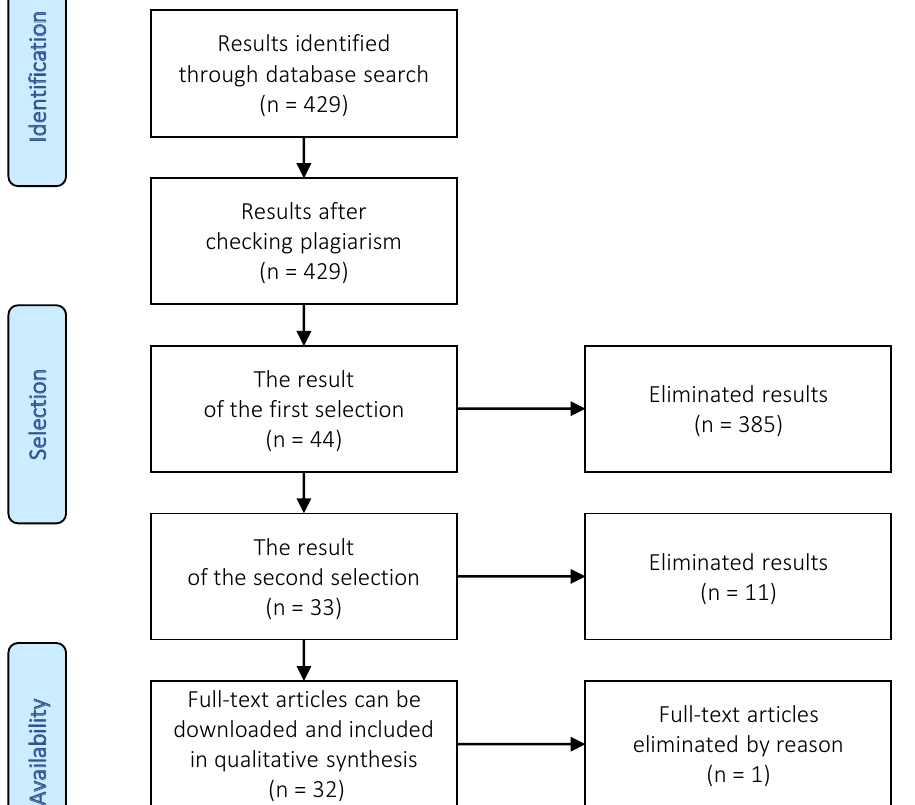
Figure 1. PRISMA process in article